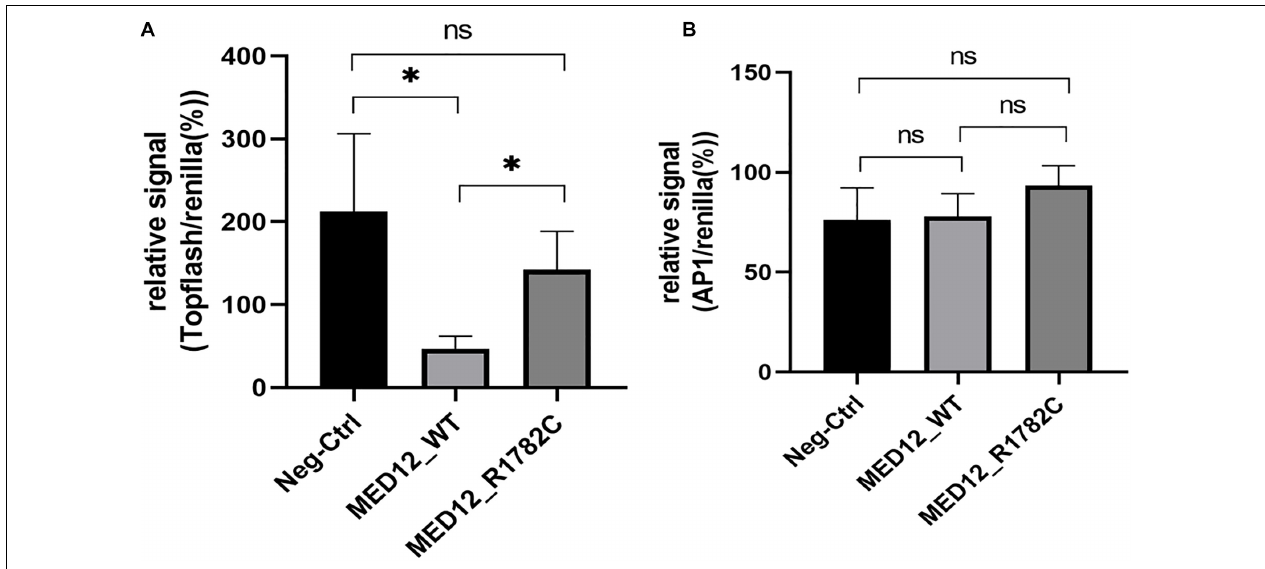
FIGURE 4 | The influence of MED12 p.Arg1782Cys on the expression of WNT signaling pathway. (A) The variant of MED12 affected the non-canonical WNT signaling pathway. Luciferase assay was performed among HEK293T cells. Top-flash relative signal to Renilla represents the canonical WNT signaling. * p < 0.05. Ns: not significant. (B) The effect of the variant of MED12 on the canonical WNT signaling pathway. Luciferase assay was performed among HEK293T cells. AP1 represents non-canonical WNT